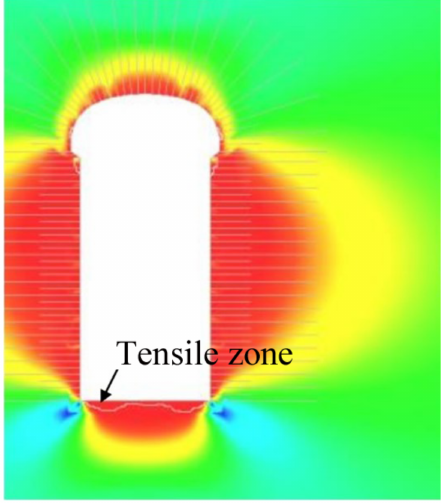
Figure 9. Tensile zone distribution resulting from dynamic analyses.